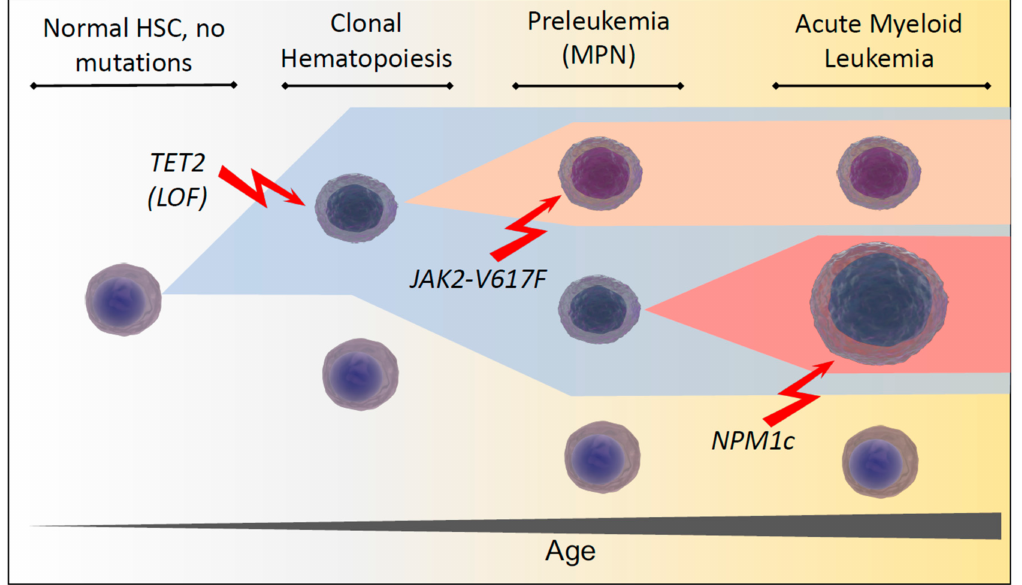
Figure 1. Schematic of clonal development in hematopoietic stem and progenitor cells during aging. Representative example of the sequence of TET2 loss of function (LOF), Janus Kinase 2 (JAK2-V617F) and Nucleophosmin (NPM1c) mutations leading to clonal hematopoiesis, a myeloproliferative neoplasia (MPN) and finally to the development of acute myeloid leukemia (AML)